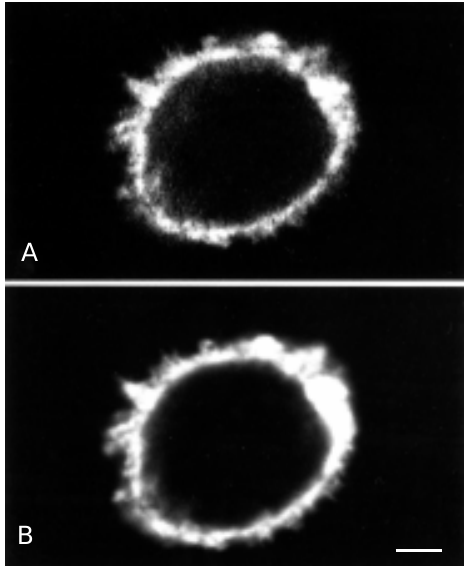
Figure 9 - Dual localization of internalized fluo-NT and immu- noreactive NT-1 receptor in COS-7 cells transfected with cDNA encoding the NT-1 recep- tor tagged with an immuno- genic epitope (VSV). Cells were incubated for 5 min with 20 nM fluo-NT, fixed with paraformal- dehyde and immunolabeled for the tagged NT-1 receptor. Note that at this short time point there is complete overlap in the distribution of ligand (A) and re- ceptor (B) confirming that inter- nalization implicates receptor- ligand complexes. Scale bar: 5